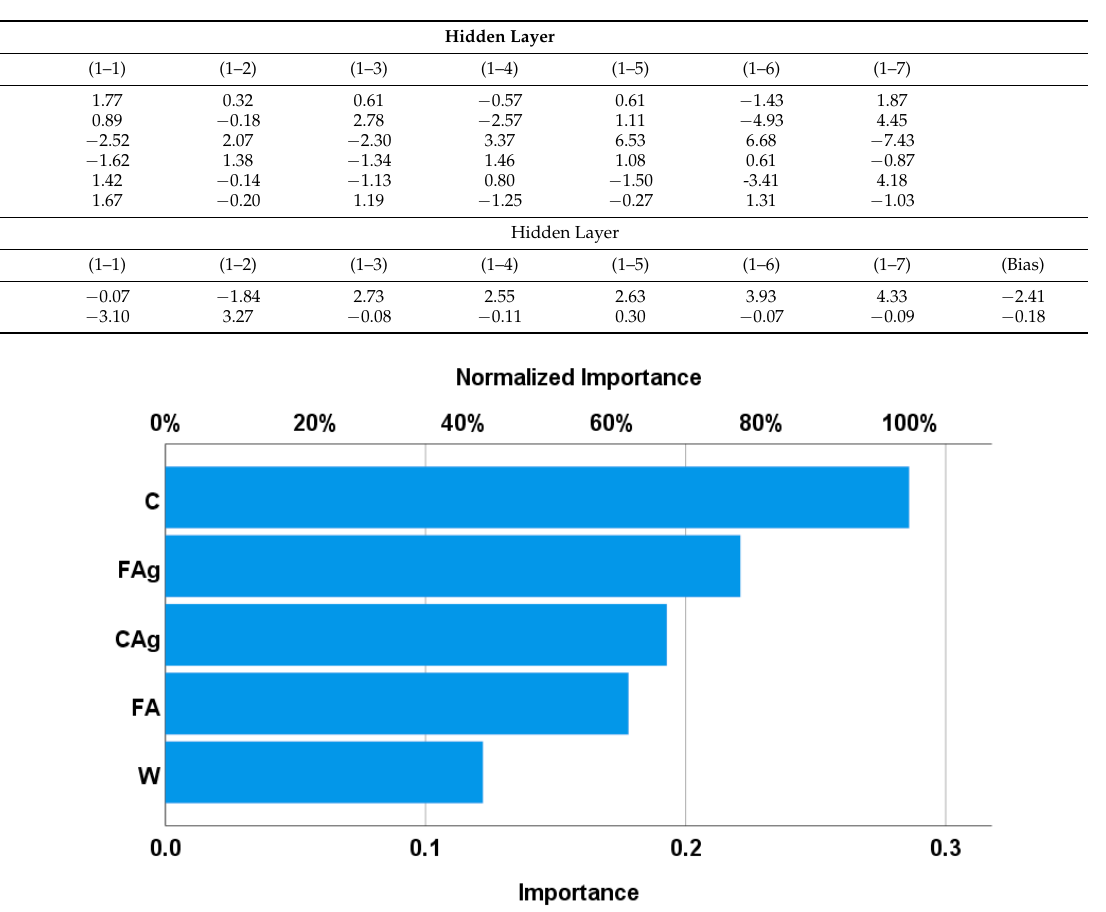
Table 6. Weights matrix for the developed ANN-GA model.